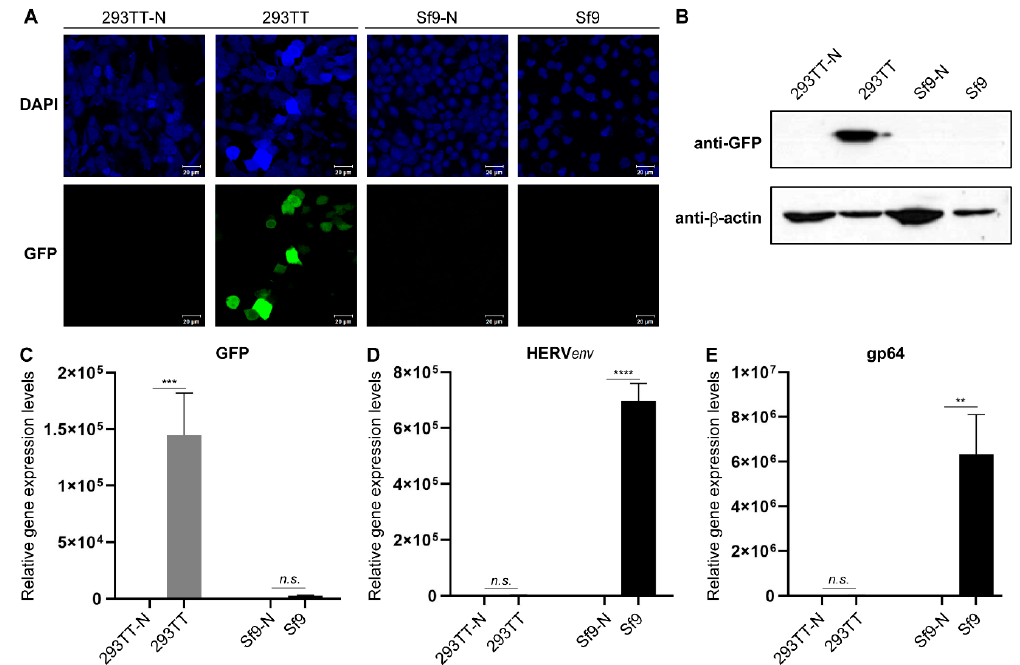
Figure 2. Expression levels of representative genes controlled by mammalian and baculovirus promoters. ( A ) Fluorescence images of CMV promoter-regulated GFP expression in AcHERV env -CMV-GFP-infected 293TT and Sf9 cells. 293TT-N and Sf9-N were used as uninfected controls, respectively. DAPI visualizes nuclei. Scale bars in all fluorescence images, 20 μ m. ( B ) Western blot analyses of GFP expression in AcHERV env -CMV-GFP-infected 293TT and Sf9 cells. The levels of GFP protein were assayed using anti-GFP antibody and normalized relative to β -actin levels, used a loading control. qRT-PCR analyses of ( C ) GFP, ( D ) baculovirus promoter-regulated HERV env , and ( E ) gp64 expression in AcHERV env -CMV-GFP-infected 293TT and Sf9 cells. GFP, HERV env , and gp64 RNA levels were normalized to 18s rRNA levels. Results are shown as the means ± s.e.m. of six independent replicates. ** p < 0.001, *** p < 0.0001, **** p < 0.00001. n.s ., not significant.